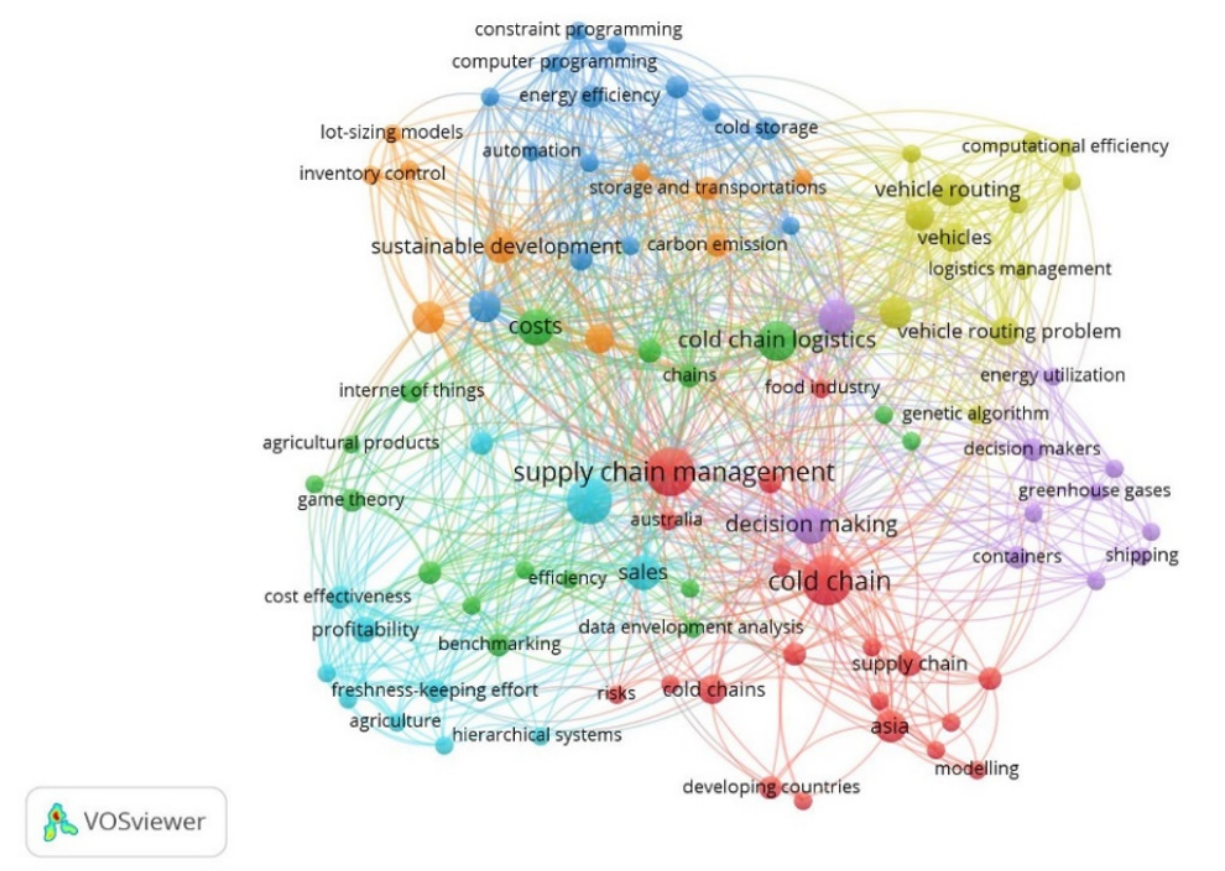
Figure 1. Vosviewer keyword co-occurrence analysis (Bibliographic map). After VKCA, four themes were identified from seven clusters, viz., digitalization (green), inventory (red and orange), transportation (blue, pink, and cyan), and sustainability (purple). Fifteen enablers were identified from the four themes. In Table 1, the details of the fifteen enablers of PFSC has been provided. Table 1. Fifteen enablers from Vosviewer keyword co-occurrence analysis.